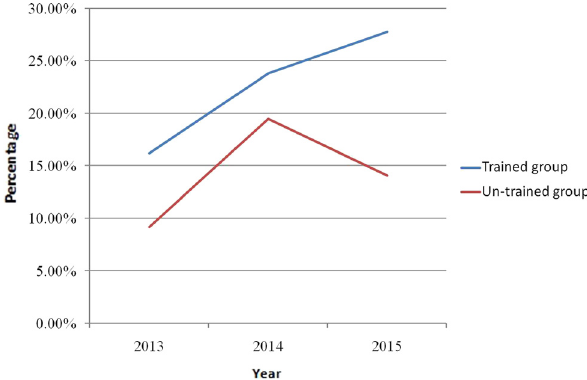
Figure 3: The rate of bisphosphonate use in the patients with hip fracture intrained group and untrained group between 2013 and